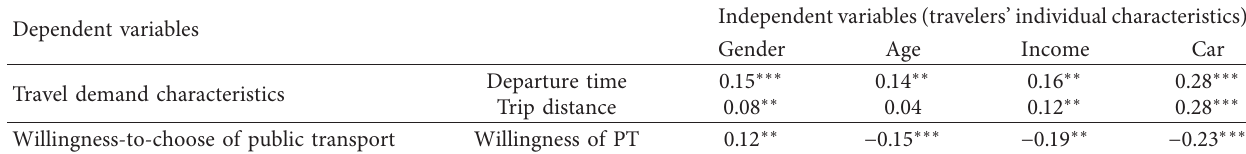
Table 7: Influence of travelers’ individual characteristics on the endogenous